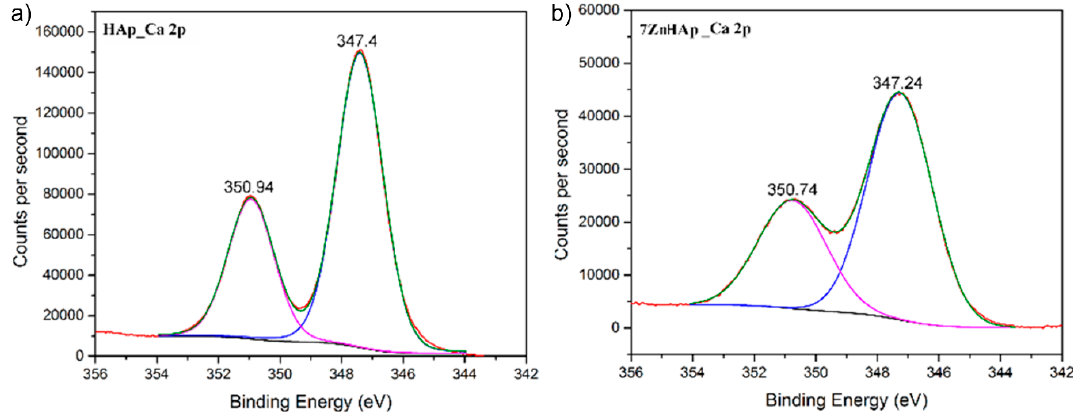
Figure 5. The high-resolution XPS spectra for Ca 2p of HAp ( a ) and 7HApZn samples ( b ).